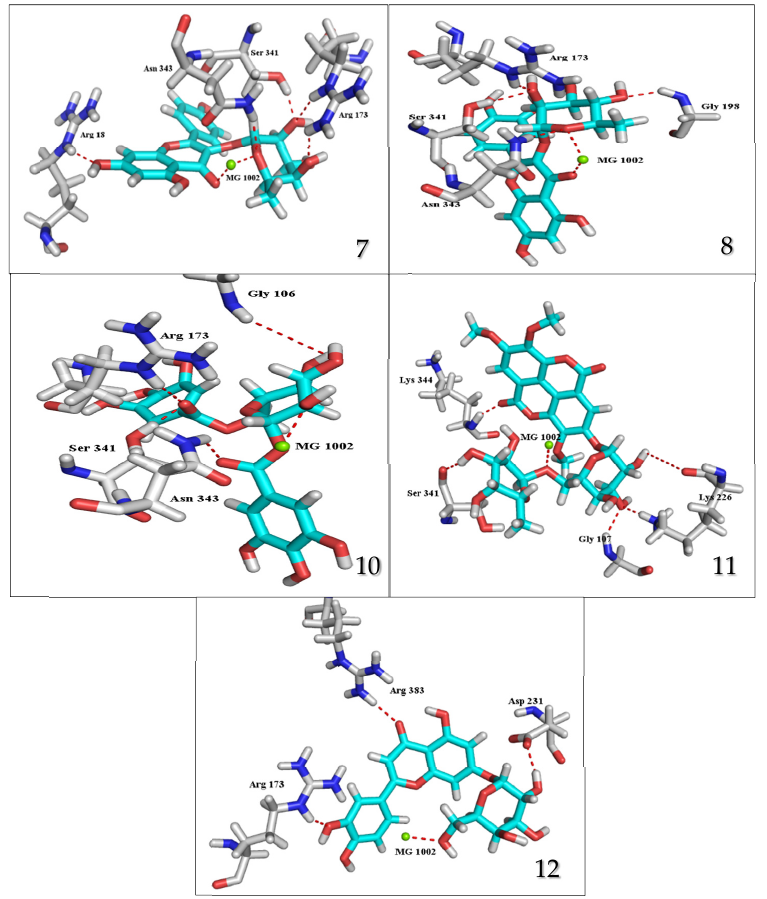
Figure 5. 3D interaction caption of the top docking pose of the most active isolated compounds.